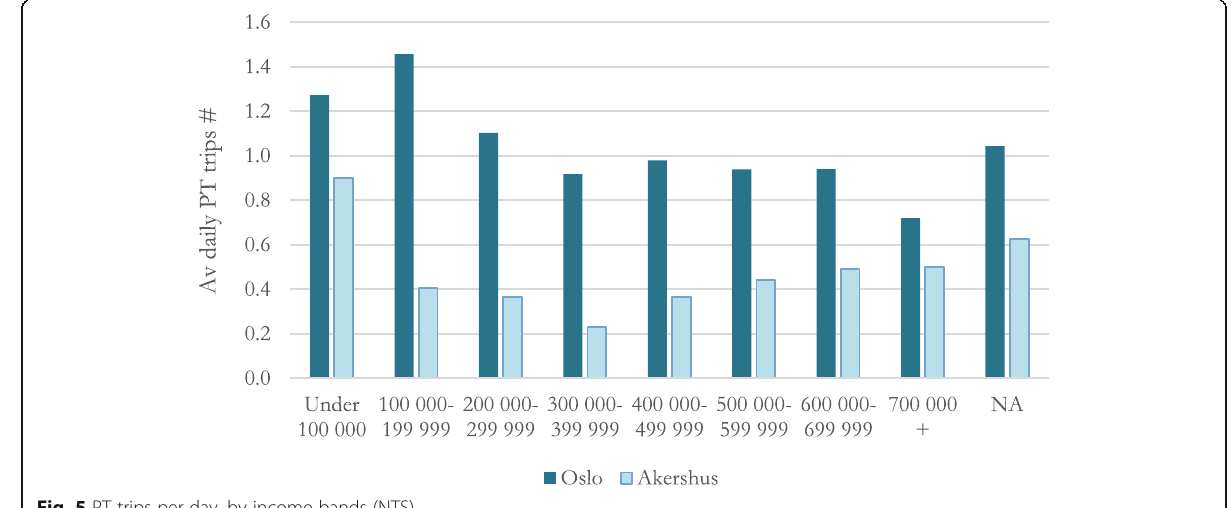
Fig. 5 PT trips per day, by income bands